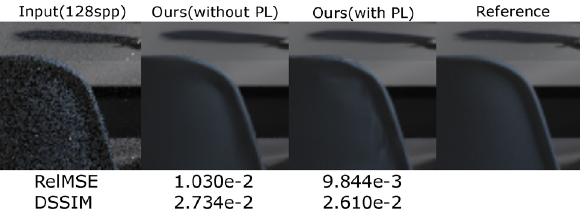
Fig. 14 Limitations of training with perceptual